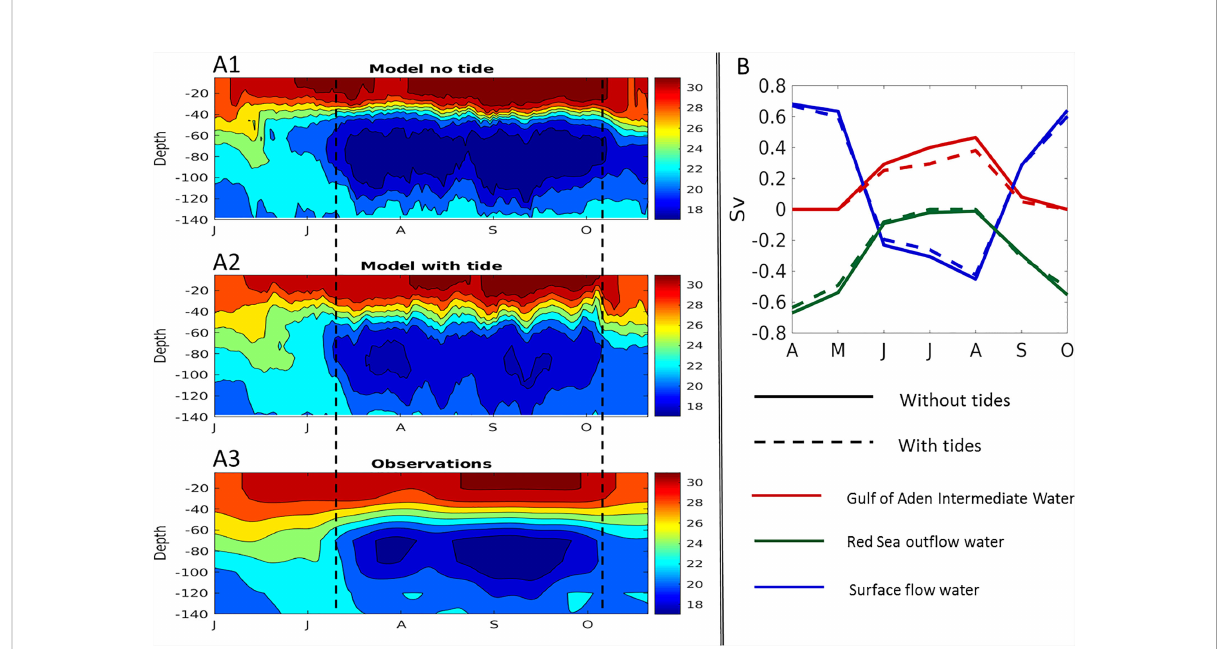
FIGURE 2 A comparison of model results and observations. Panels (A1), (A2) , and (A3) represent the Hovmo¨ ler diagrams of the temperature fi eld from the model run without tides, the model run with tides and the observations, respectively. The data in ( A3) is run through a low-pass fi lter with a 20-day frequency. Panel (B) plots the monthly mean layer transport volumes at the BAM strait from the model